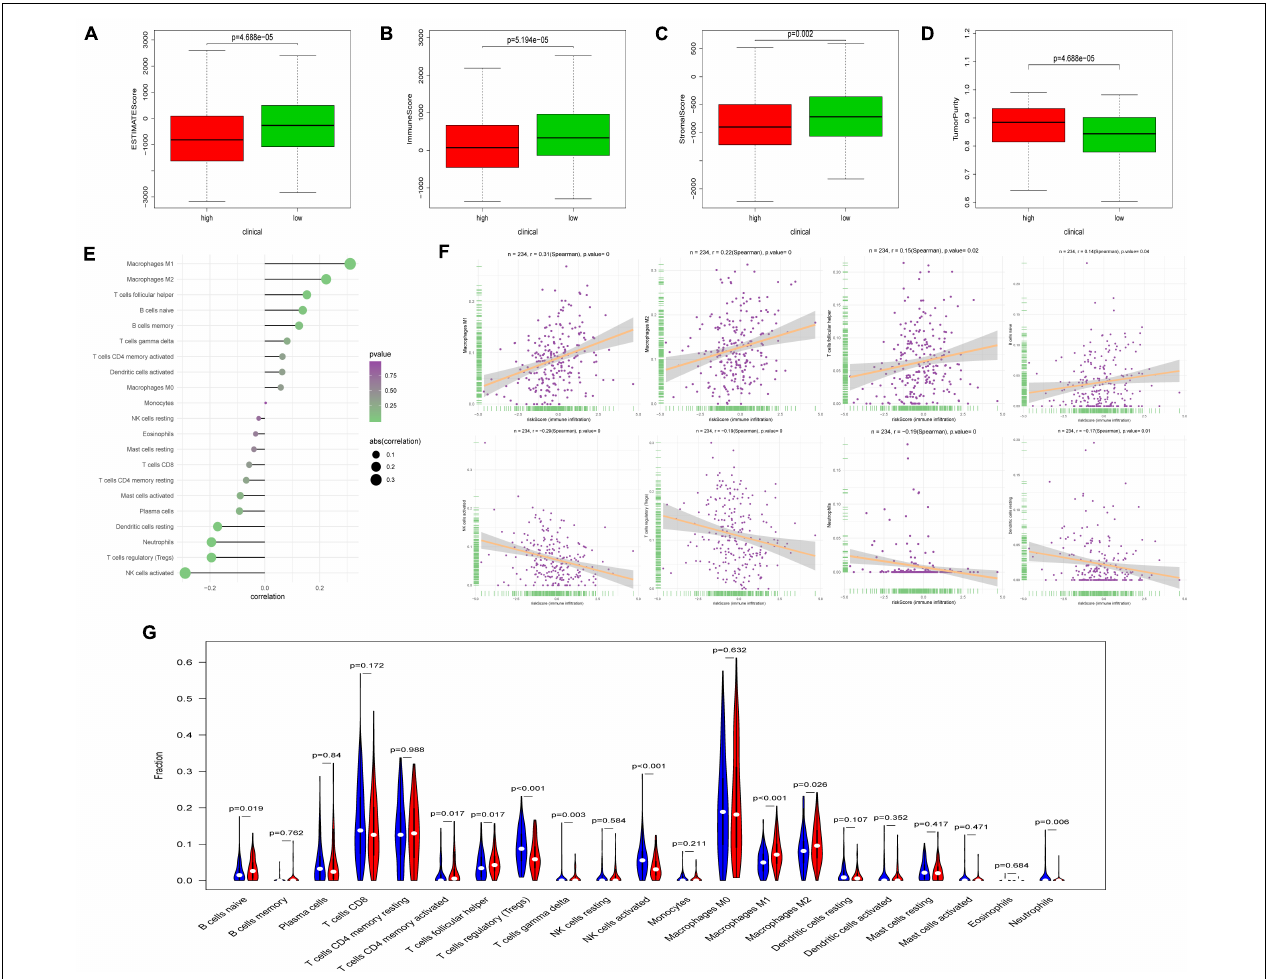
FIGURE 6 | Correlation between FRPS and immune cell infiltration. (A–D) The correlation between FRPS and (A) ESTIMATE Score, (B) Immune Score, (C) Stromal Score, and (D) Tumor Purity. (E) The association between FRPS and immune cell infiltration. (F) The association between IRPS and each type of immune cell. (G) The landscape of immune cell infiltration in low-risk and high-risk groups. The low-risk and high-risk groups are represented via blue and red violin, respectively.